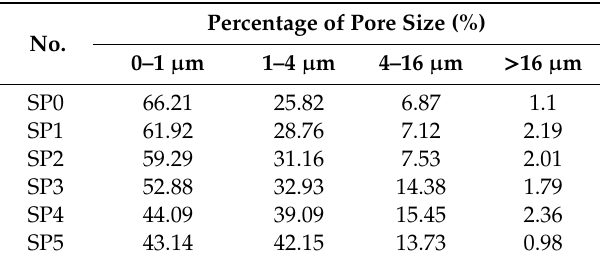
Table 13. Percentage of pore size.